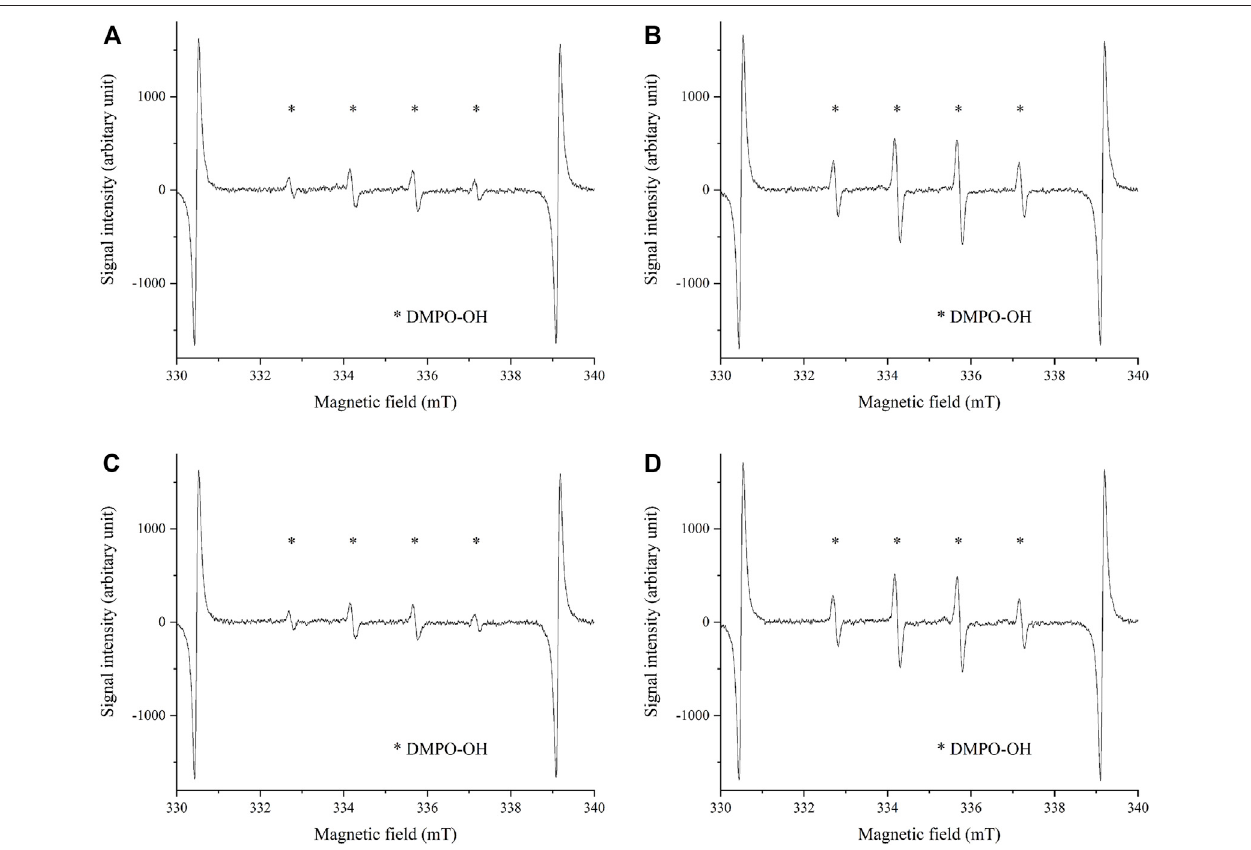
(cid:129) FIGURE7| The OHspectrum byESR methodonanodic oxidesprepared inthesodium tartrateelectrolyte withand without H 2 O 2 .Thepeaks of in both anodic oxides by ESR methods using DMPO. The sample size is n = 3 in each group. (A) UV irradiation on anodic oxide with H 2 O 2 for 5 min (B) UV irradiation on anodic oxide with H 2 O 2 for 15 min (C) UV irradiation on anodic oxide without H 2 O 2 for 5 min (D) UV irradiation on anodic oxide without H 2 O 2 for 15 min. ESR: Electron spin Resonance, DMPO: 5,5-dimethel-a-pyrroline-N-oxide.